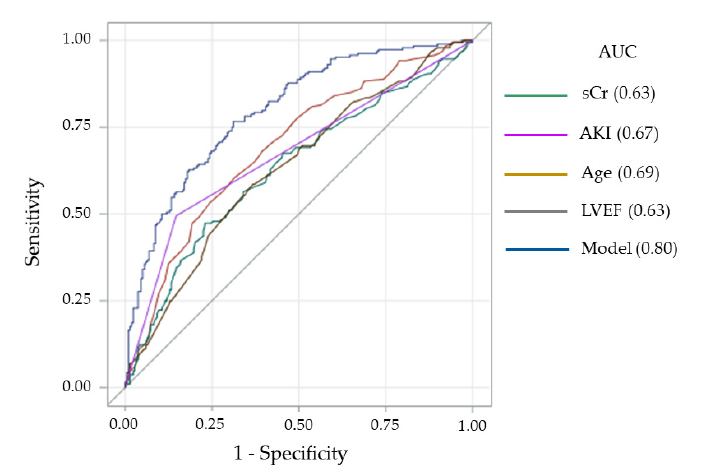
Figure 2. Receiving operating characteristic curves and corresponding area under the curves (AUC) for long-term mortality of each independent predictor considered separately and in combination (Model). AKI = acute kidney injury; LVEF = left ventricular ejection fraction; sCr = serum creatinine concentration.